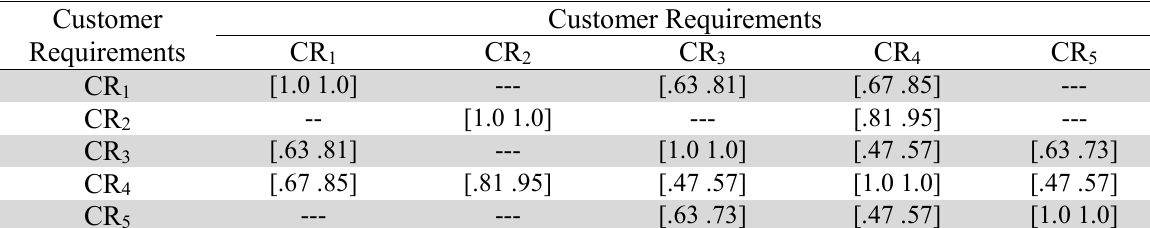
Table 2 CR correlation values (V ig ) Customer Requirements